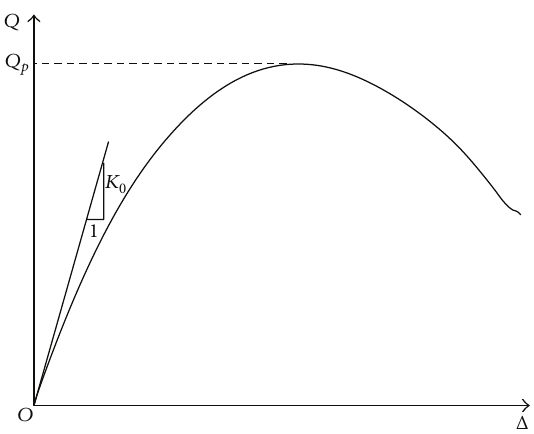
Figure 10: Force-deformation relationships for steel slit